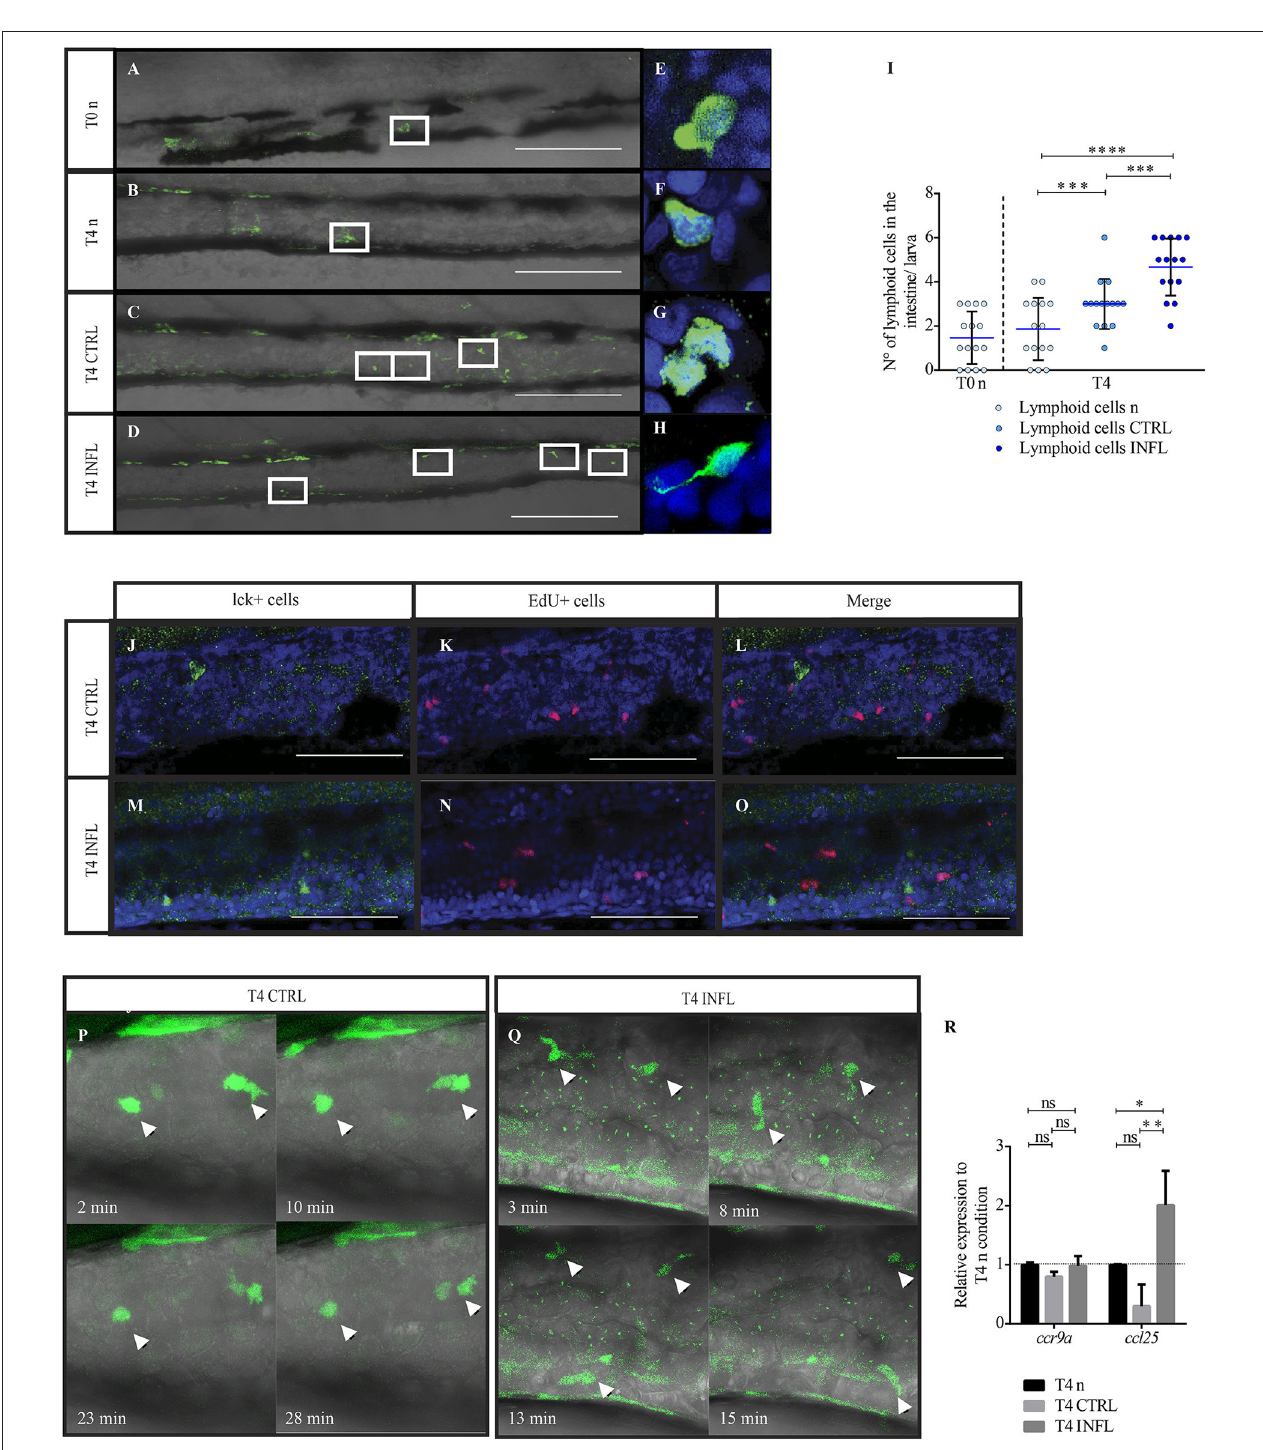
FIGURE 3 | Lymphoid cells are present in the intestine as early as 5dpf and are able to respond to food antigens. (A–D) Lateral view of the intestine from a Tg(lck:lck-eGFP) larva showing fluorescently labelled lymphoid cells (green). (E–H) Higher magnification of lymphocytes under the different conditions. (I) Quantification of lymphoid cells under the different conditions (n: naive; CTRL: control; INFL: inflammation) and time points (T0: 5 dpf; T4: 9 dpf). (J–O) T cells in control (J) or inflamed (M) intestine do not colocalize with EdU + cells (K,L,N,O) . (P) Example of migration of T cells (arrowhead) in a Tg(lck:lck-eGFP) larvae fed with control diet (derived from Supplementary Movie 1 ). (Q) Example of the migration of T cells (arrowheads) in a Tg(lck:lck-eGFP) larva fed with inflammatory diet (derived from Supplementary Movie 2 ). (R) Relative mRNA levels of ccl25 and ccr9a were analyzed in the intestine of control and inflamed larvae. Data was normalized against rpl13a and compared to naïve or maintenance condition (dotted line). * p < 0.05; ** p < 0.01; *** p < 0.001; **** p > 0.0001. Scale bar for A–D 200 µ m and J–O 100 µ m. Experiments were done at least in three biological replicates with 20 individuals per condition.